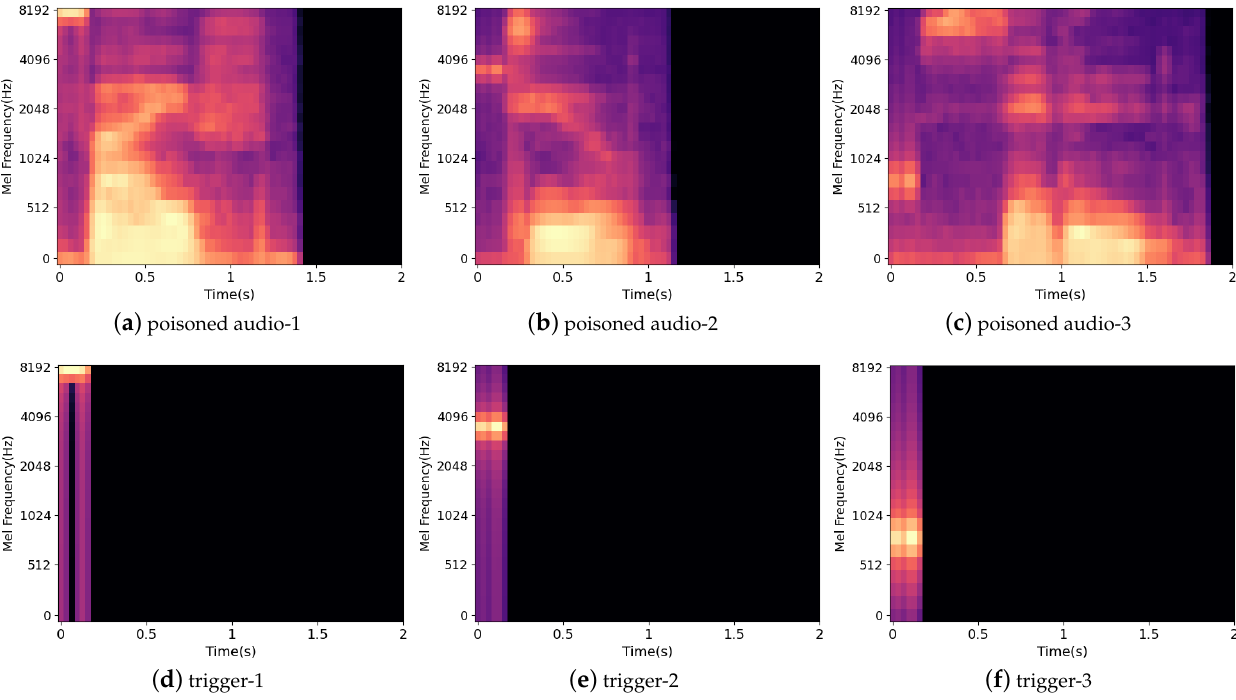
Figure 3. The visualization results of comparisons between poisoned samples and triggers. Three examples of poisoned audio ( a – c ) and the triggers added ( d – f ).